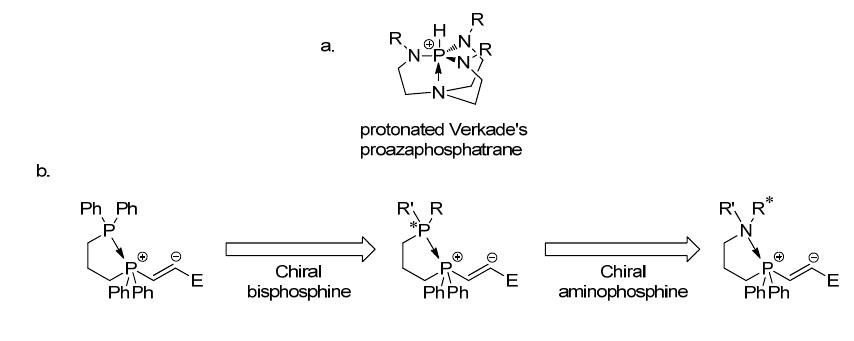
Figure 2. Possible intramolecular anchimeric assistance. ( a ) Verkade’s protonated proazaphosphatrane; ( b ) Utilization of a chiral aminophosphine instead of a chiral